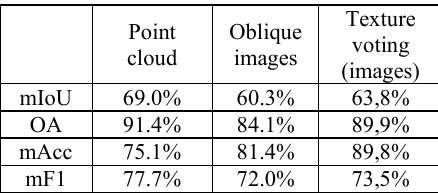
Table 6 . SUM benchmark dataset – comparison of results from different